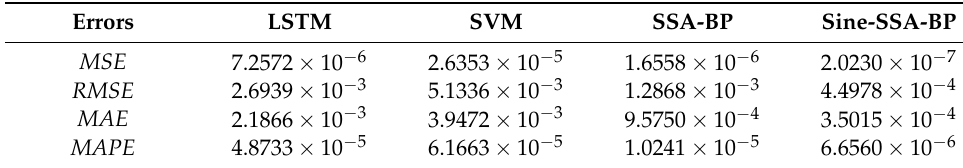
Table 3. Comparison of trajectory prediction errors in Scenario 1.